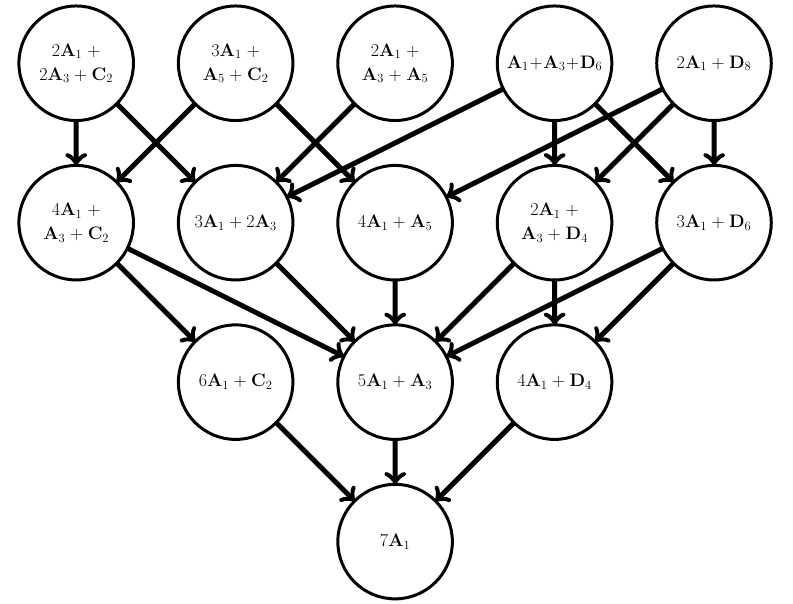
Figure 5 . Scheme of how deleting nodes in the Dynkin diagrams of maximally enhanced groups with H = Z 2 × Z 2 lead to gauge groups with lower rank and also with H = Z 2 × Z 2